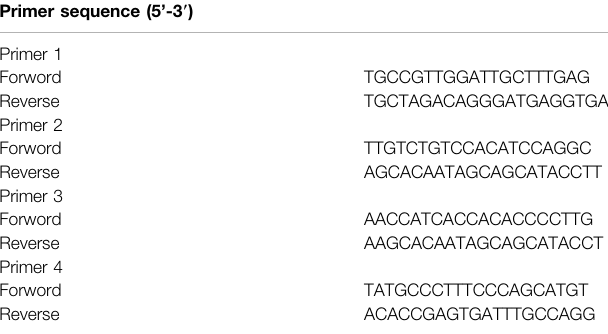
TABLE 3 | Ampli fi ed primers of ZmZFP126 gene. Primer sequence (5 ’ -3 9